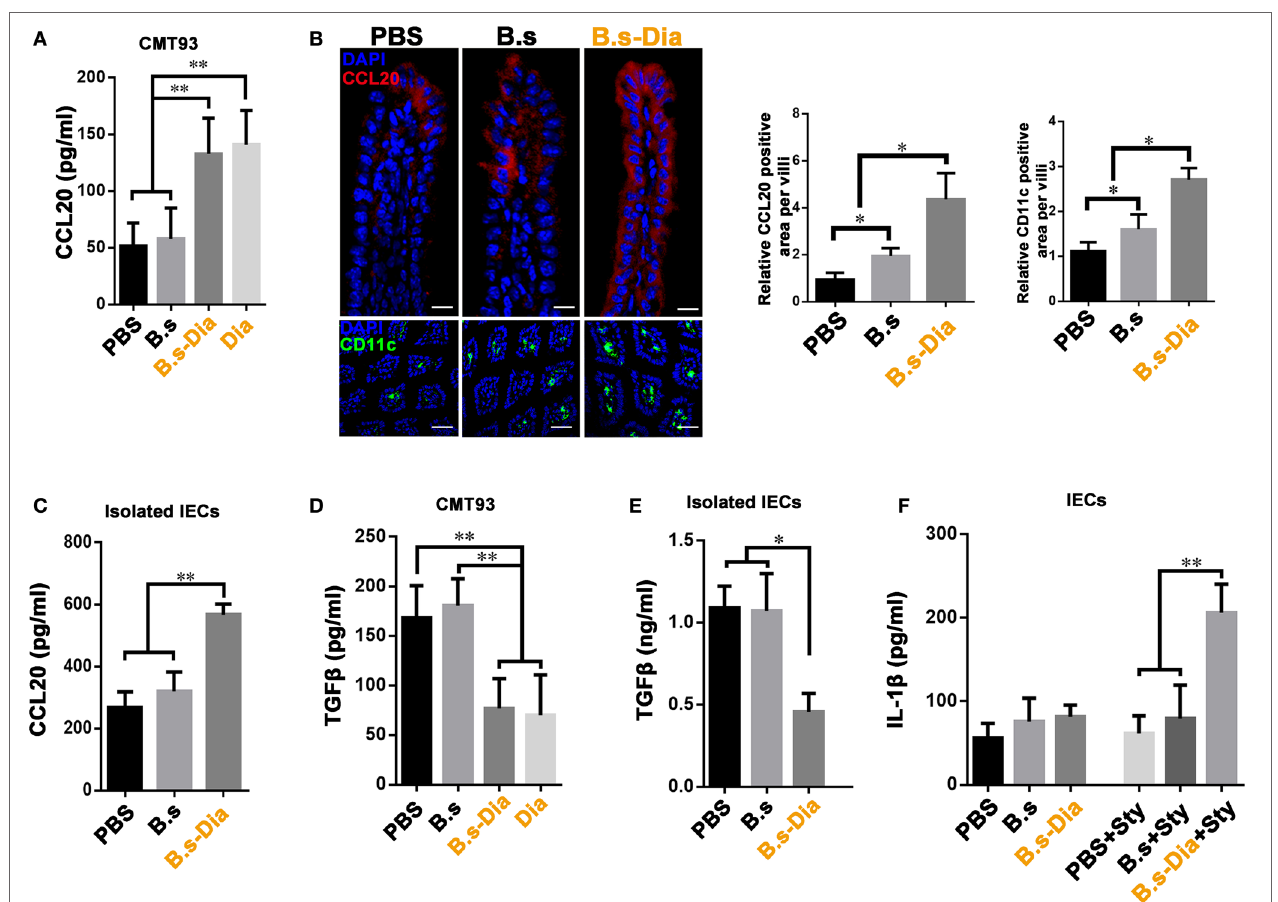
FigUre 4 | gavage administration of 4,4 ′ -diaponeurosporene-producing Bacillus subtilis (B.s-Dia) markedly increased intestinal epithelial cell (iec)-derived ccl20 and reduced TgF β production . (a,D) CMT93 cell was treated with 1 µM 4,4 ′ -diaponeurosporene, 1 × 10 7 colony forming units (cfu) B.s or B.s-Dia, the amounts of CCL20 in cultural supernatant were measured by ELISA. (B) Mice were intragastrically administrated of PBS, 1 × 10 9 cfu B.s or B.s-Dia for 7 days, the expression of CCL20 (red) in IECs of the indicated mice were detected by confocal microscope. The staining of CD11c + cells (green) were shown in below panels. Scale bar, 50 µm in above panel and 100 µm in the below panel. (c,e) The epithelial cell layer was digested as described in Section “Materials and Methods” and cultured for 6 h at 37°C. The amounts of cytokines CCL20 or TGF β in cultural supernatant were measured by ELISA. (F) Mice were intragastrically administrated of PBS, 1 × 10 9 cfu B.s or B.s-Dia for 7 days followed by Salmonella typhimurium gavage (Sty), and the production of IL-1 β were detected as described in (c) . One representative of three similar independent experiments is shown. Asterisks indicate statistical significance via the one-way ANOVA test (** P < 0.01, * P <